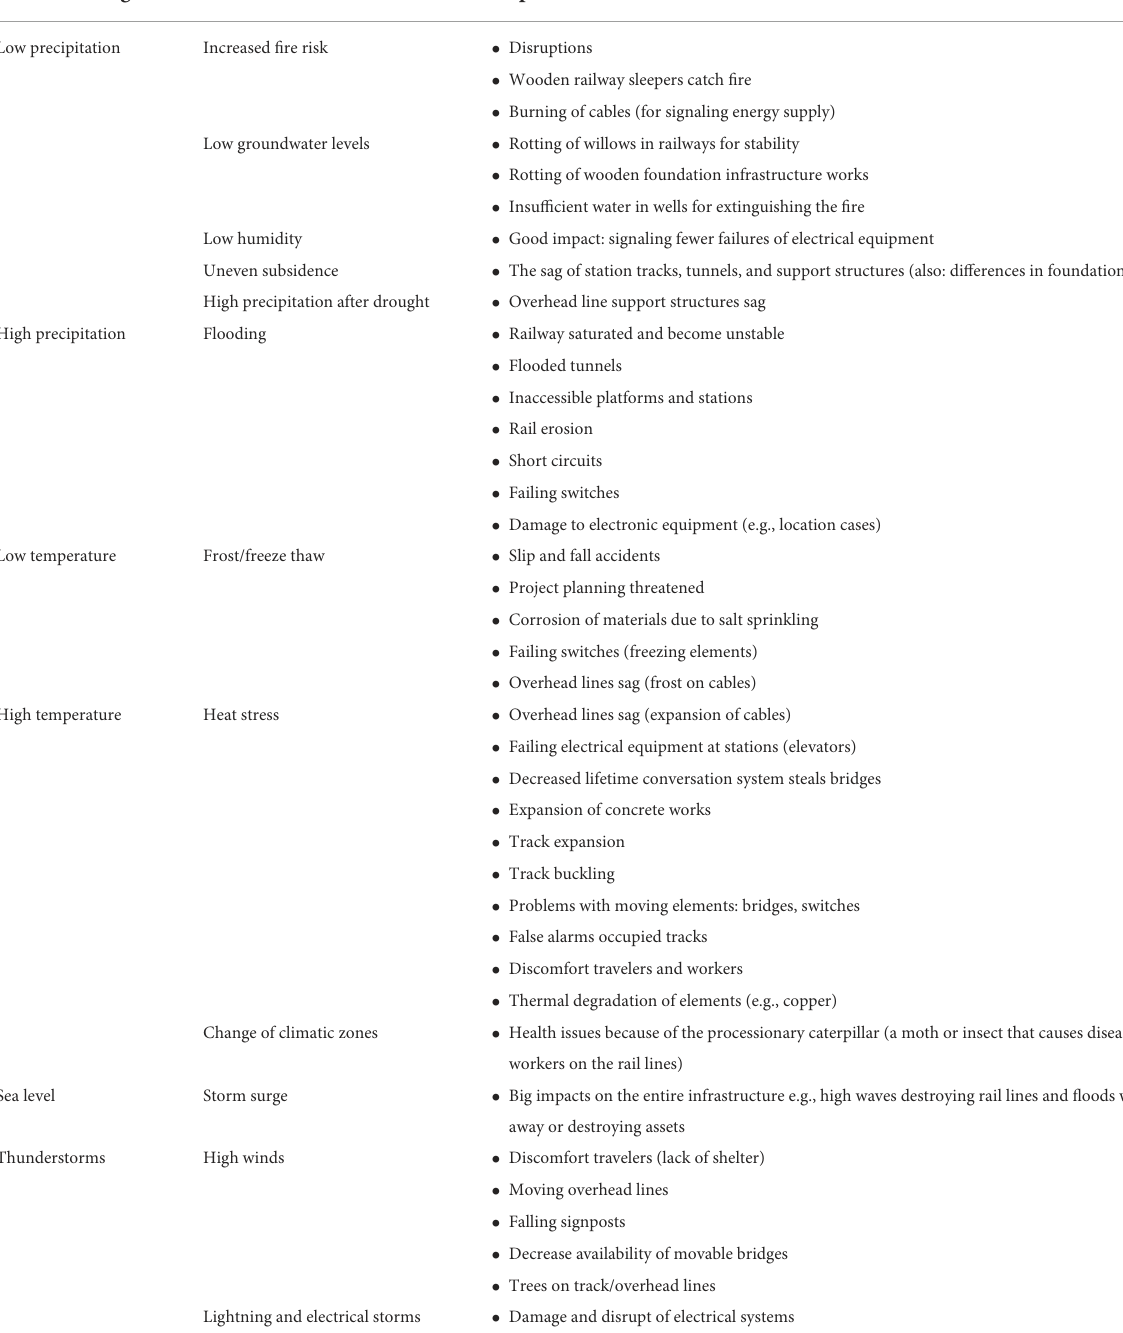
TABLE 1 Identified climate change